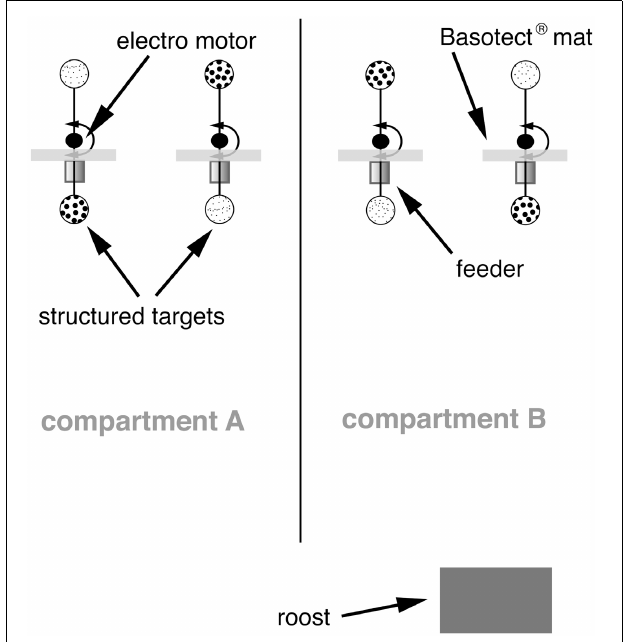
FIGURE 1 | Experimental room and training apparatus. The room was divided into two compartments, which were connected at one end. Two feeders were placed at the other end of each compartment. Above each feeder, one of two different structured targets were presented. Targets could be replaced by an electro motor. The motor, valves and other targets that should not be presented were completely hidden behind sound-absorbing Basotect®